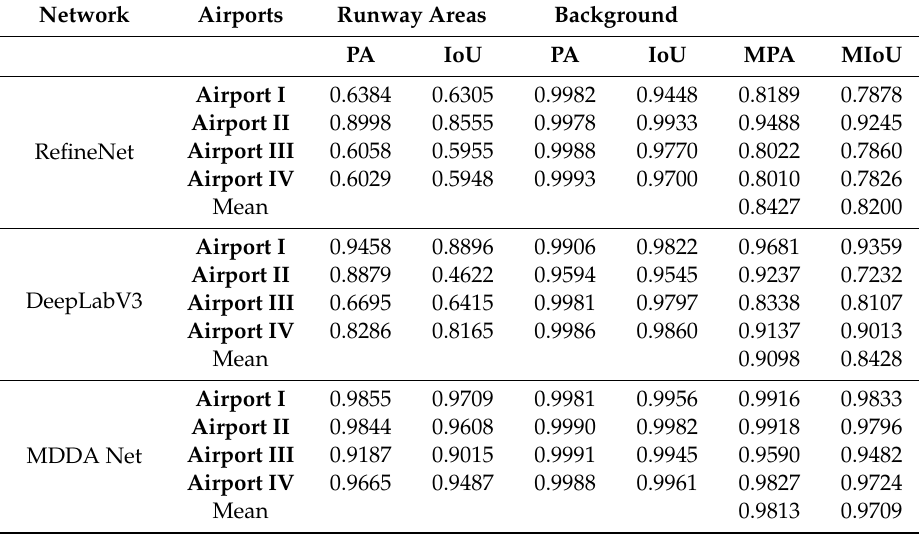
Table 2. The extraction accuracy for augmented airports by di ff erent